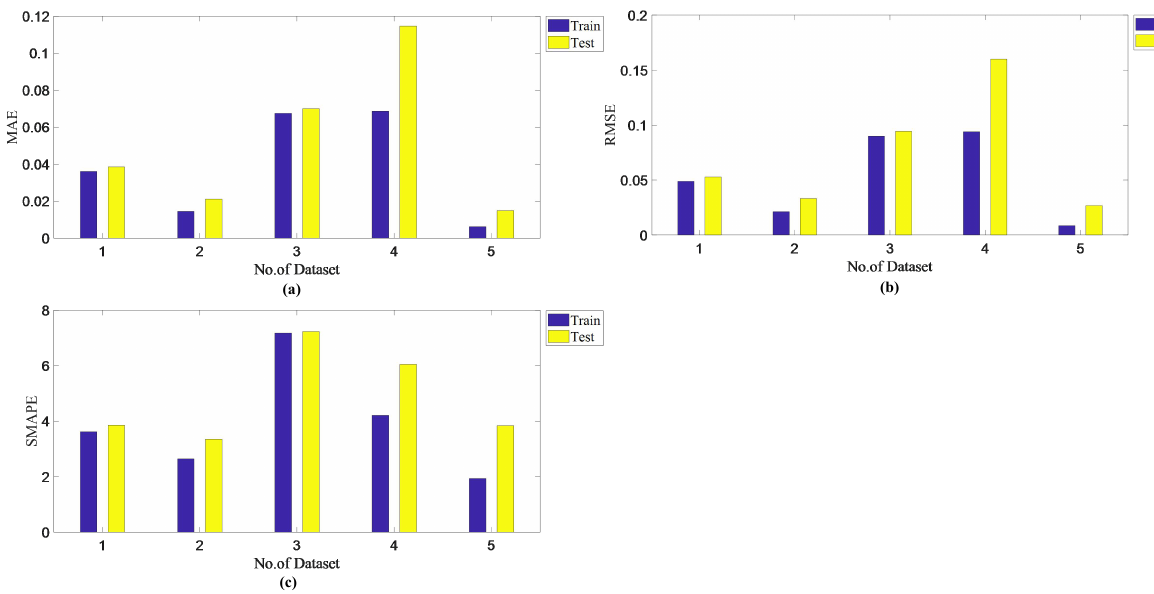
Figure 11. Performance of the DNFS on the five datasets for the training and testing. ( a ) The test MAE comparison. ( b ) The test RMSE comparison. ( c ) The test SMAPE